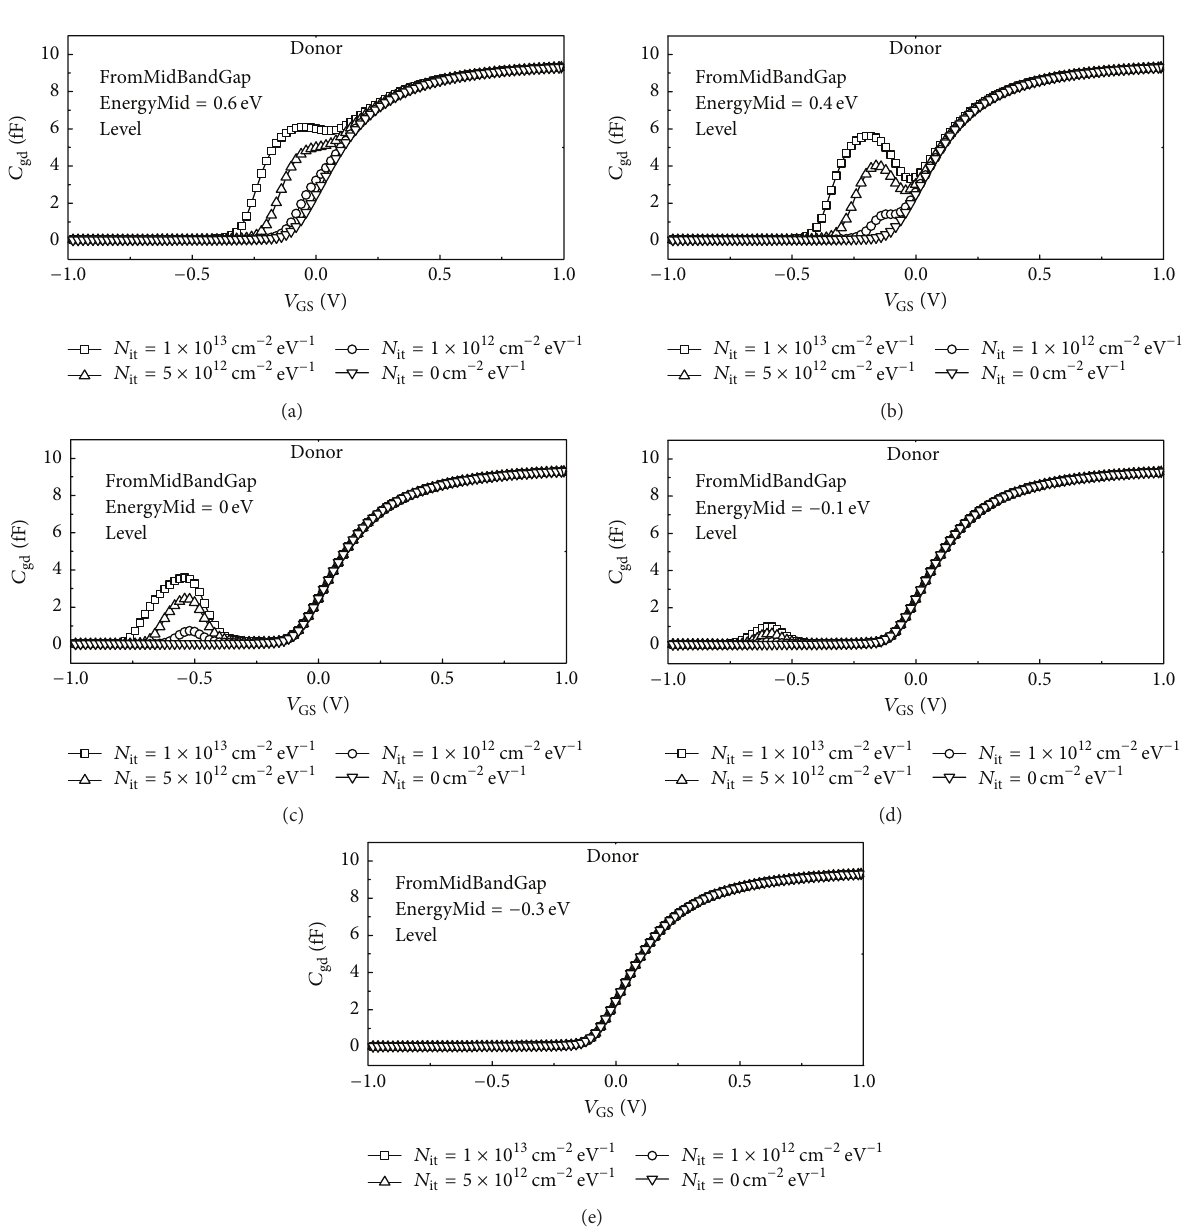
Figure 16: Miller capacitance 𝐶 of DG-TFET for donor-type ITs is studied at 𝑉 gd distributed at the energy level 0.6 eV above the midgap, (b) at the energy level 0.4 eV above the midgap, (c) at the midgap, (d) at the energy level 0.4 eV under the midgap, and (e) at the energy level 0.6 eV under the